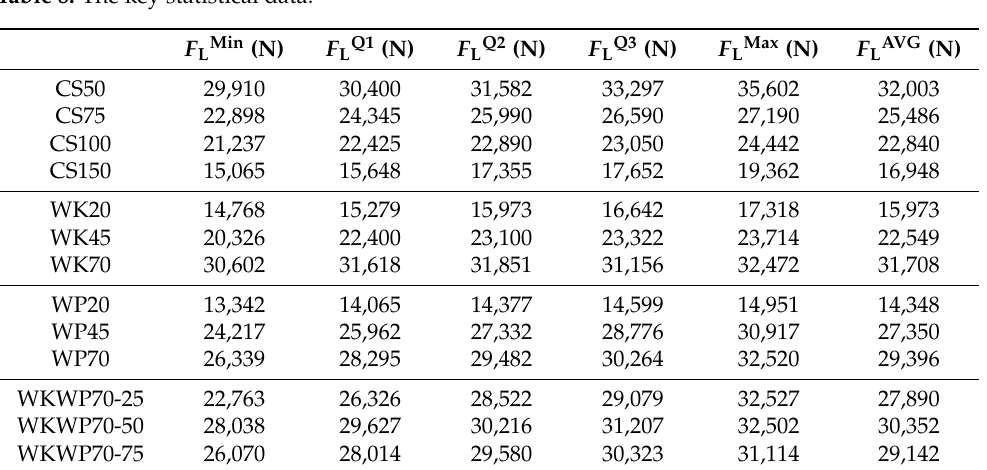
Table 8. The key statistical